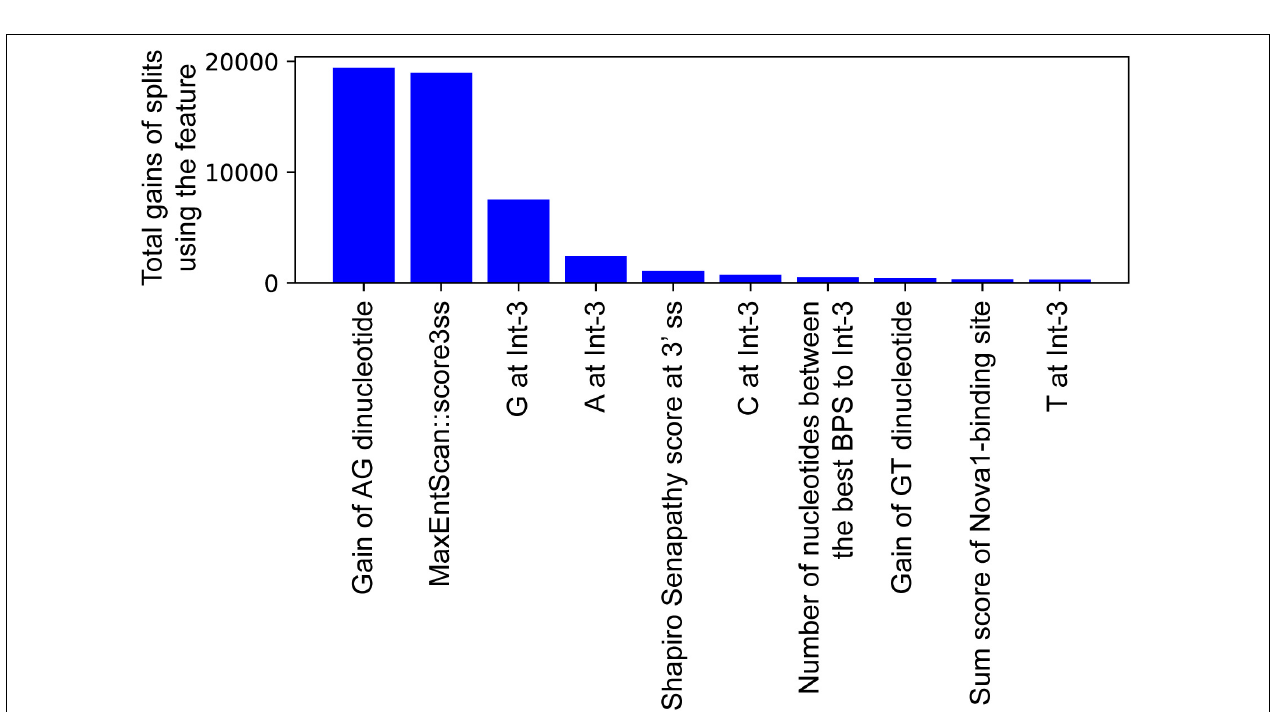
FIGURE 2 | The top 10 important features of IntSplice2 in 110